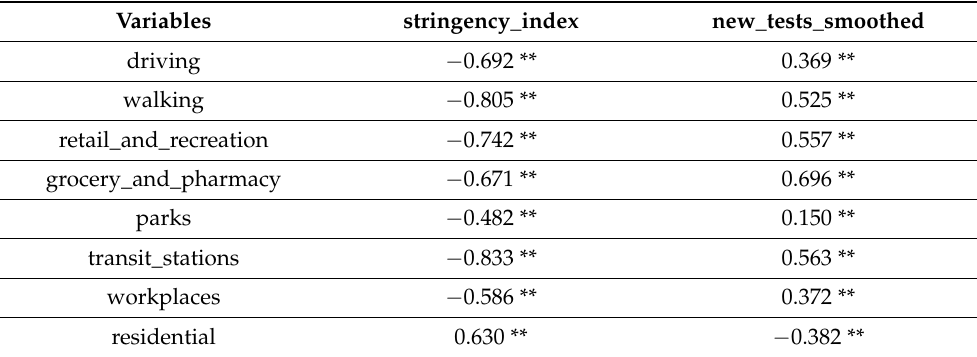
Table 4. Spearman’s r s correlation indexes calculated between variables indicating restrictions and mobility in